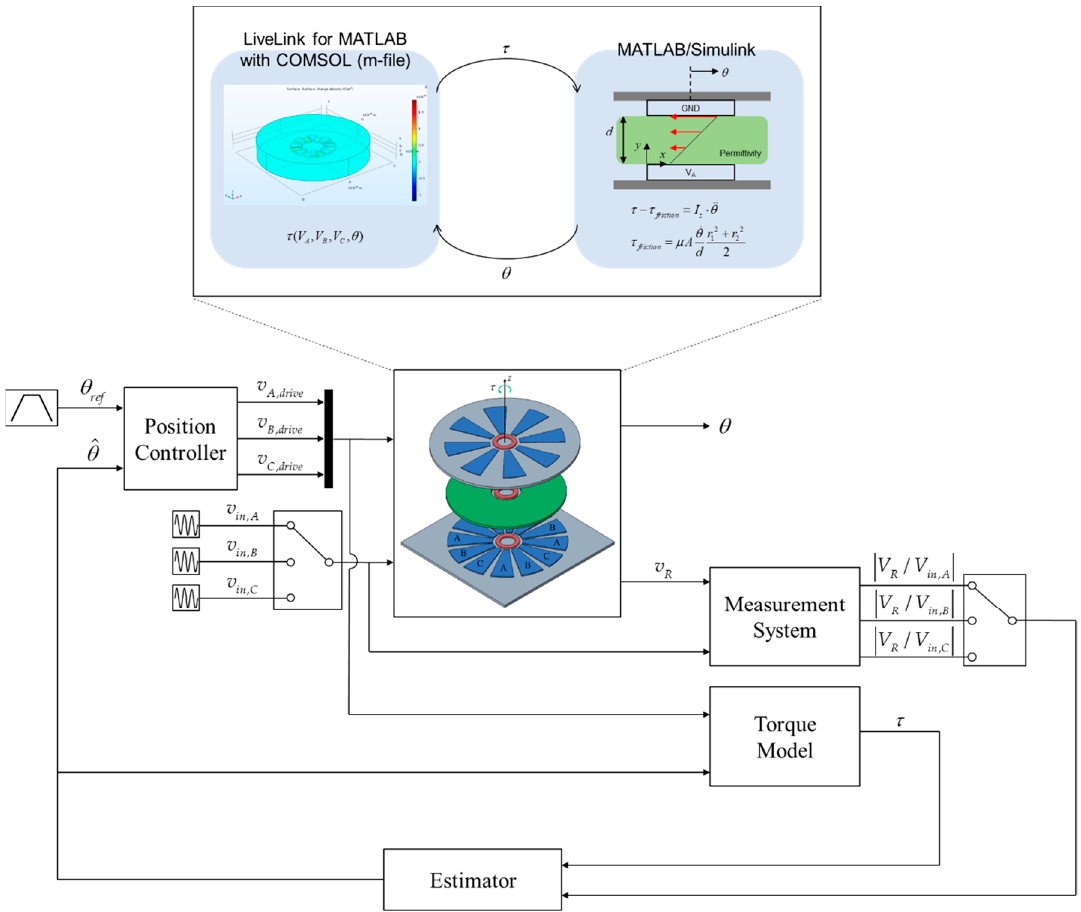
Figure 13. Diagram of the proposed system .